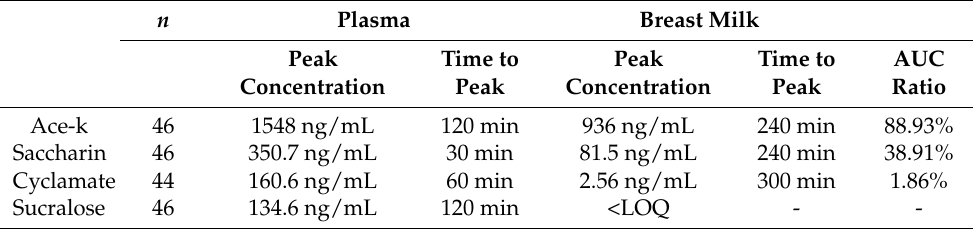
Table 2. Peak concentration, time of peak, and area under the curve (AUC) for each sweetener. n Plasma Breast Milk Peak Time to Peak Time to Concentration Peak Concentration